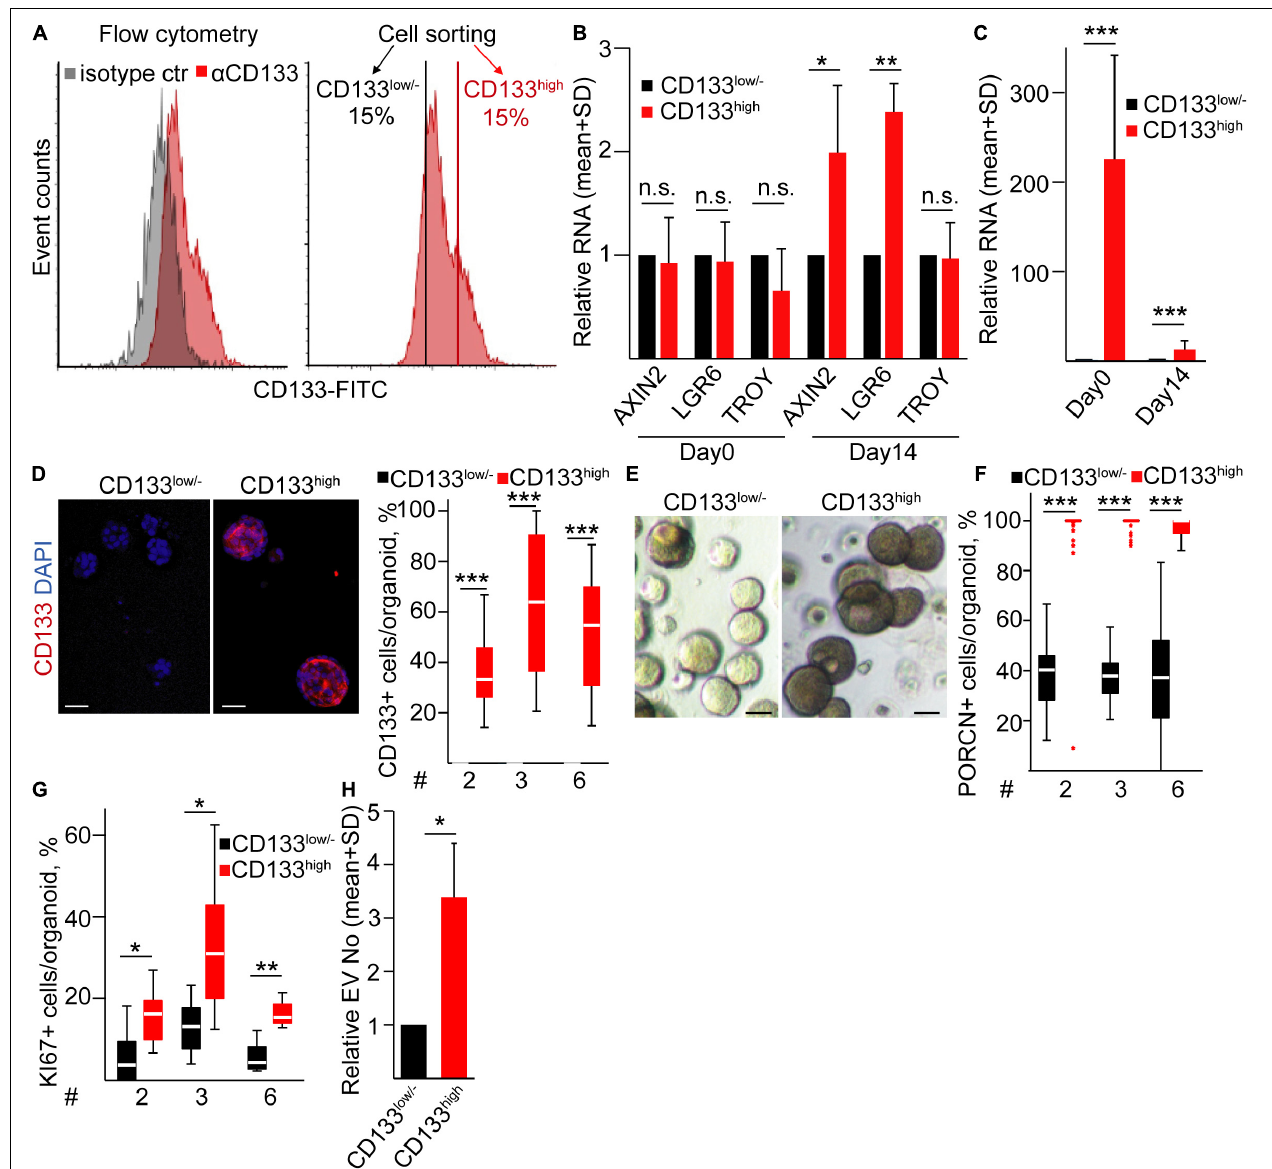
FIGURE 6 | CD133 high LUAD cells produce organoids with a high proliferation rate and EV release. (A) CD133 expression on LUAD organoid cells and the strategy for sorting CD133 high and CD133 low / − cells (flow cytometry and cell sorting). (B) Relative RNAs for AXIN2 , LGR6 , and TROY from freshly sorted cells (day 0) or from organoids initiated by CD133 high or CD133 low / − cells, measured on day 14 (RT-qPCR, n = 4). Data were normalized to HPRT1 housekeeping, and RNA levels of the CD133 high population were then compared to the CD133 low / − results in each sorting experiment. (C) Relative RNA level of CD133 from the sorted cells (day 0) and organoids initiated by these cells (day 14). Normalized RNA level from the CD133 low / − population was taken one (RT-qPCR, n = 4). (D) Immunostaining for CD133 and the quantification of confocal microscopic images in organoids derived from sorted cells (CD133 low / − or CD133 high ) on day 14 ( n = 3). (E) Bright-field microscopic images of organoids initiated by the indicated sorted LUAD cell populations. (F,G) Percentage of PORCN + (F) and KI67+ (G) cells in the organoids derived from sorted CD133 low / − and CD133 high cells on day 14. (H) Relative EV number from CD133 low / − or CD133 high cell-derived organoids on day 14 (NTA, n = 4). Data were normalized to 10 6 cells before comparisons. Data for three LUAD samples are shown in panels (D,F,G) with 10–15 images analyzed from three replicates. One-sample t -test (B,C,H) or Mann–Whitney U -test (D,F,G) were used with * p < 0.05, ** p < 0.01, and *** p < 0.005. Scale bars: 50 µ